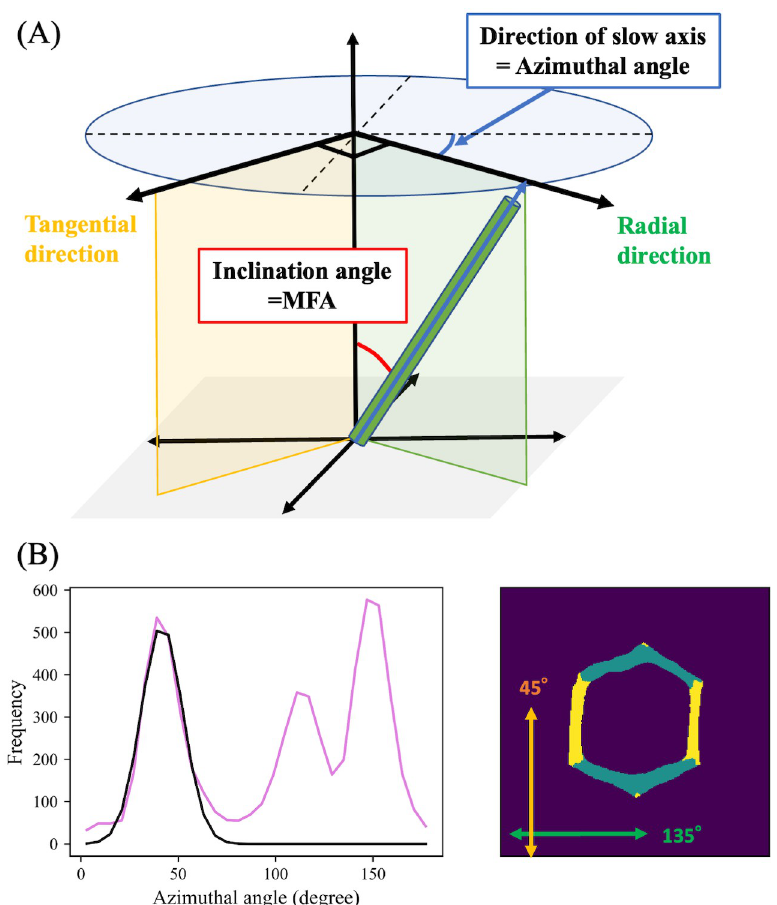
Fig 3. Azimuthal angle calculation from retardation imaging, and selective radial and tangential wall extraction from azimuthal angle distributions. (A) Definitions of azimuthal angle, and radial and tangential directions in the present experimental condition. Radial and tangential planes are colored green and yellow, respectively. (B) Azimuthal angle distribution (left, purple line) of a hexagonal-shaped tracheid (right). Tangential and radial walls are defined as pixels whose azimuthal angle is near to 45˚ (left: Area covered by the black curve; right: Yellow pixels, directions of yellow double-headed arrows) or the remaining parts (right: Green pixels).